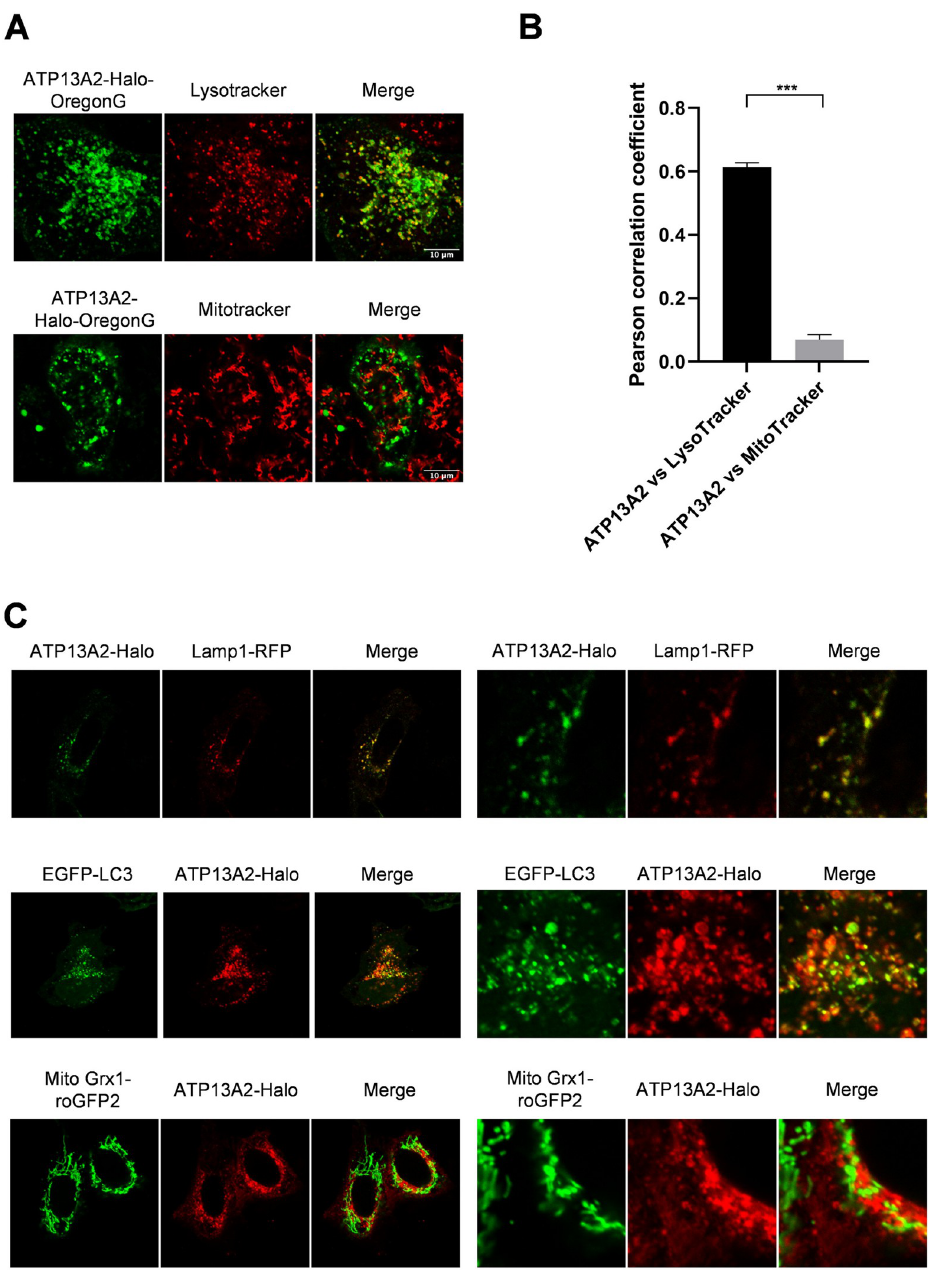
Fig 2. Intracellular localization of ATP13A2-Halo in HeLa cells. (A) Images of live cells stained with indicated fluorophores. ATP13A2-Halo was labeled with Oregon Green by utilizing Halo link technology. Scatter plots are also shown in S2 Fig (B) Pearson correlation coefficients of ATP13A2-Halo and Lysotracker or Mitotracker. Data represent averages of n = 10 samples with S.E.M. (bars). Statistical analysis was performed using Student’s t test: � p < 0.05, �� p < 0.01, ��� p < 0.001. (C) Organelle-specific proteins were cotransfected with ATP13A2-Halo. For obtaining high resolution images, cells were fixed and subjected to immunostaining using anti-ATP13A2